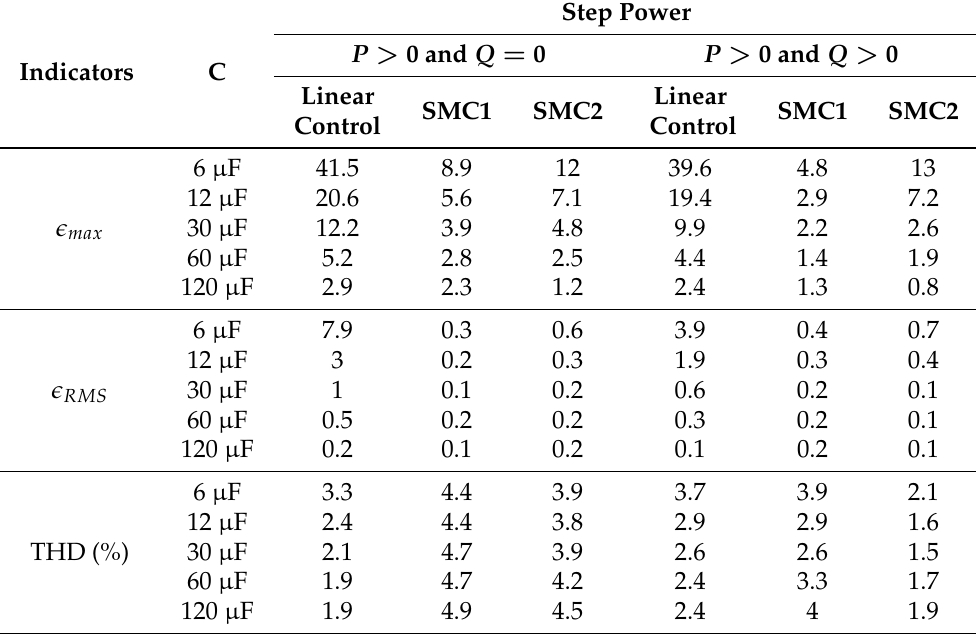
Table 2. Comparison of the errors, (cid:101) max and (cid:101) RMS , and the THD line current obtained by the three algorithms in the case of step